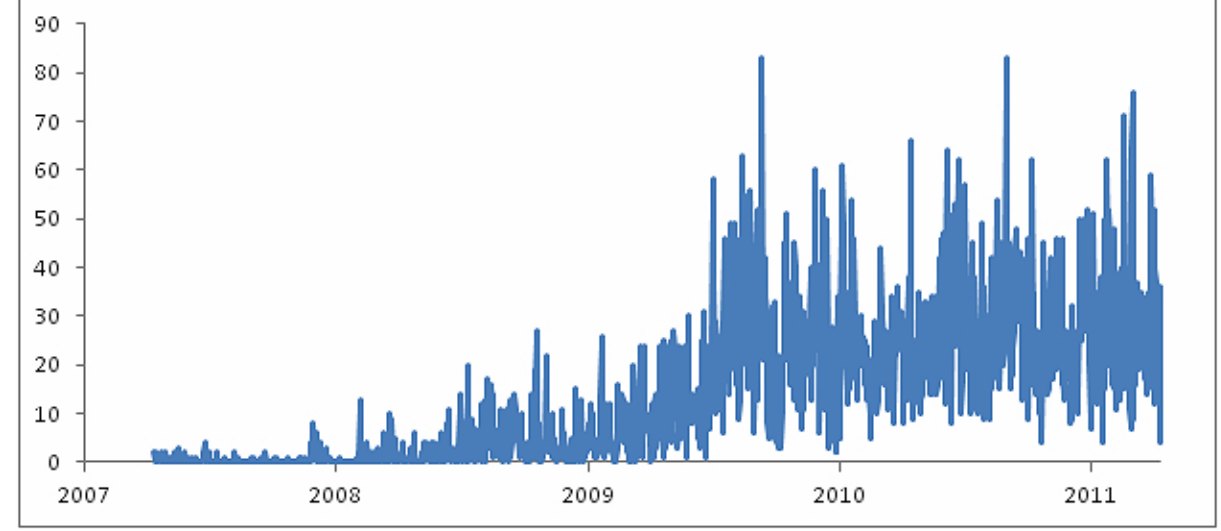
Figure 3. Historical evolution of messages per day posted at the Dominant Community